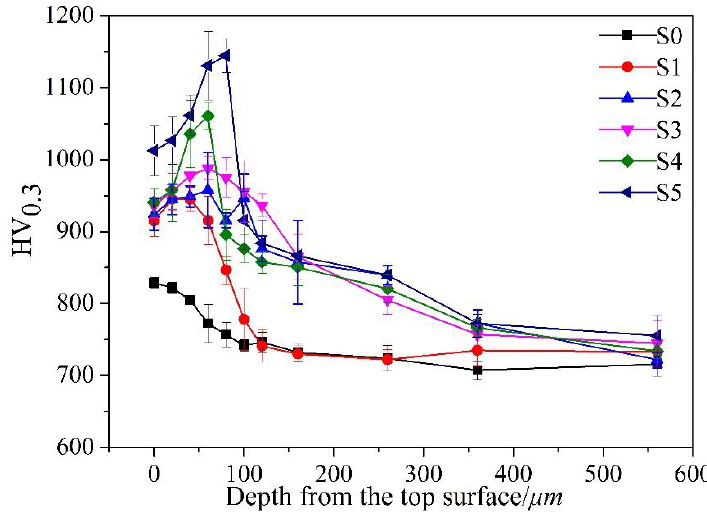
Figure 6. Microhardness as a function of the depth from the surface.